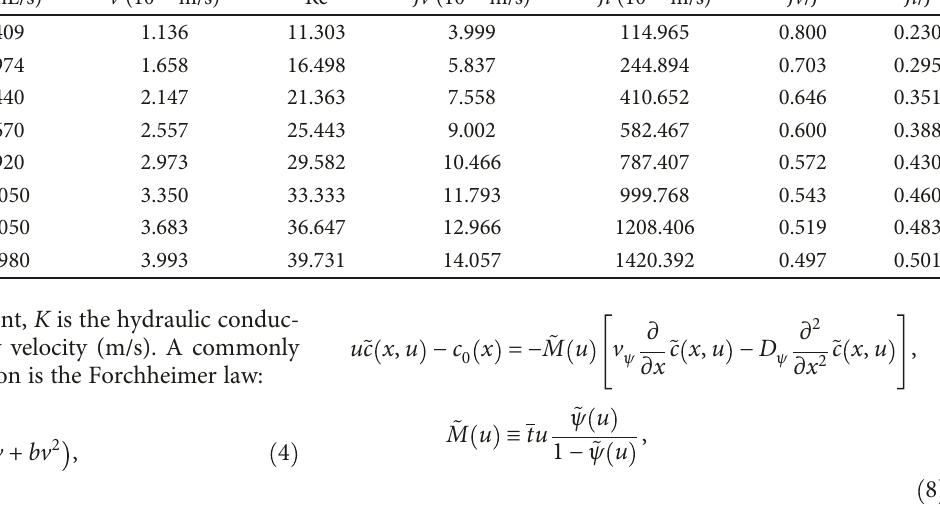
Table 1: Values of lost head, J , discharge ( Q ), v , Re, and relevant hydrodynamic parameters. Δ h